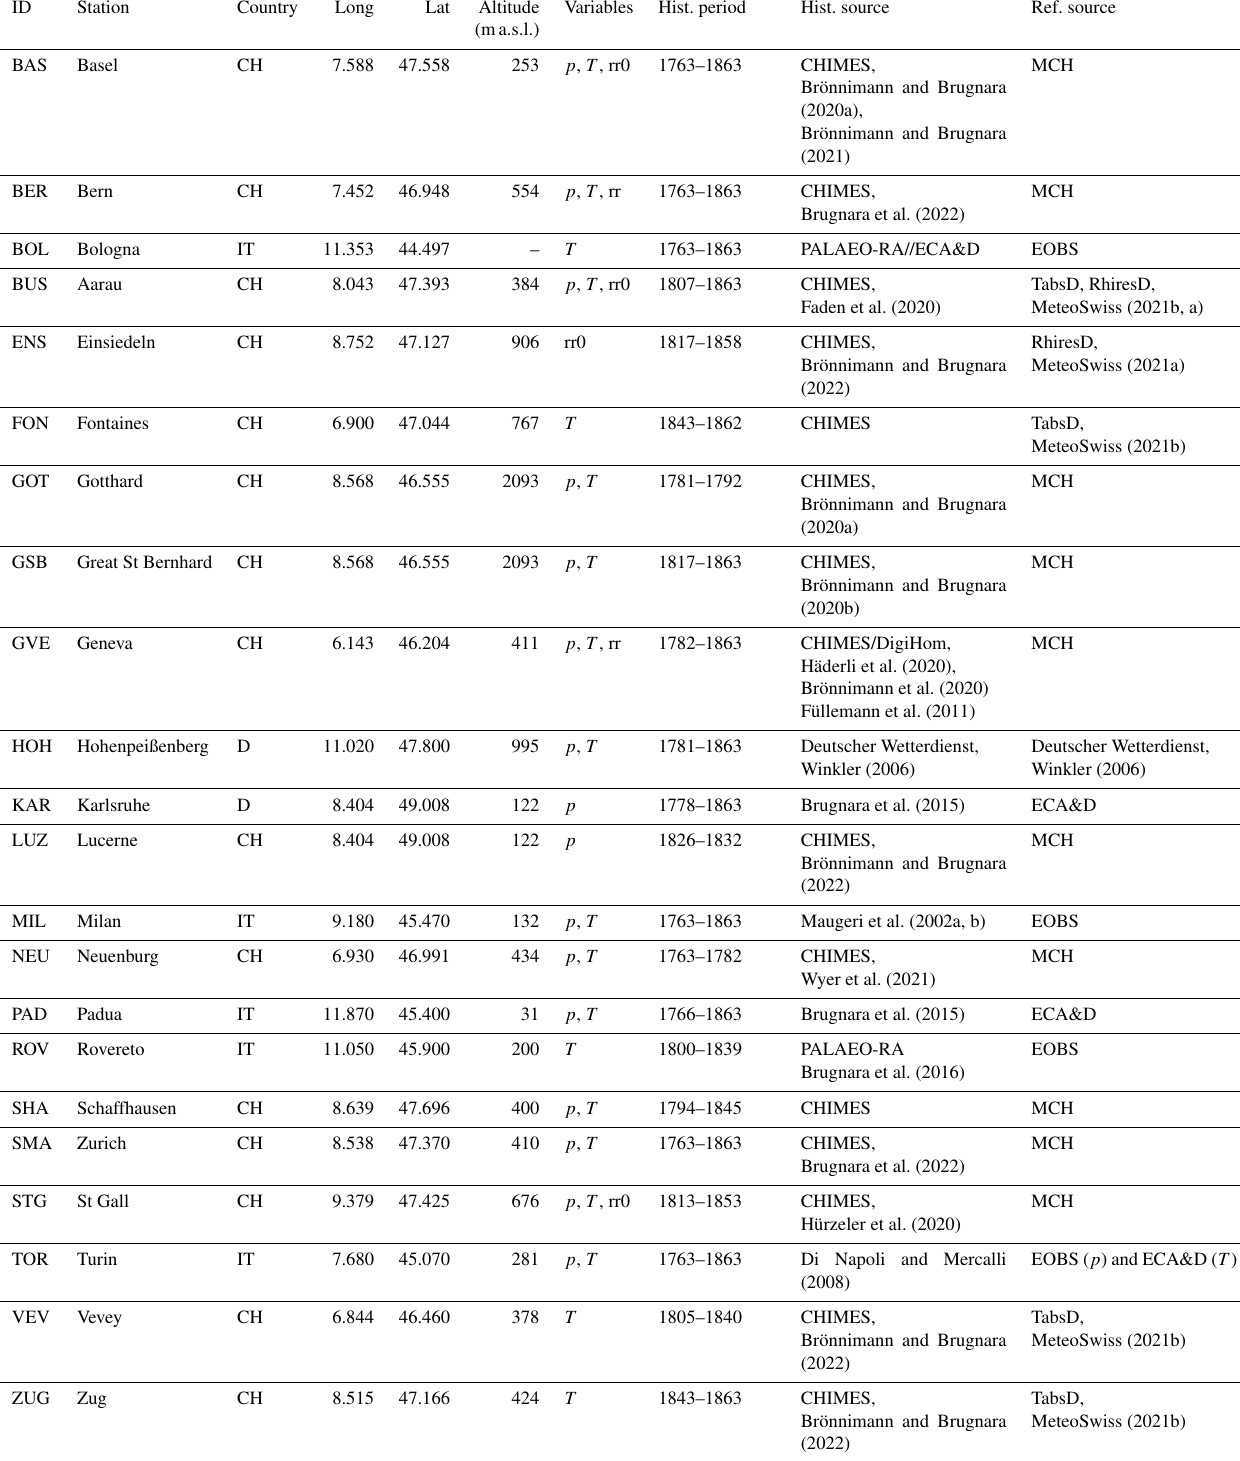
Table 1. Stations used for the reconstruction of the 1763 to 1863 period. The letters for the variables are as follows: p – pressure; T – air temperature; rr – precipitation rate; rr0 – precipitation occurrence. A description of the CHIMES data set and where it is available is found in Brugnara et al. (2020b). If additional evaluations of the station exist, the respective reference is noted in the column “Hist. sources”. For the reference data, MCH denotes station observations from the Swiss National Weather Service. For further abbreviations, refer to Sect.